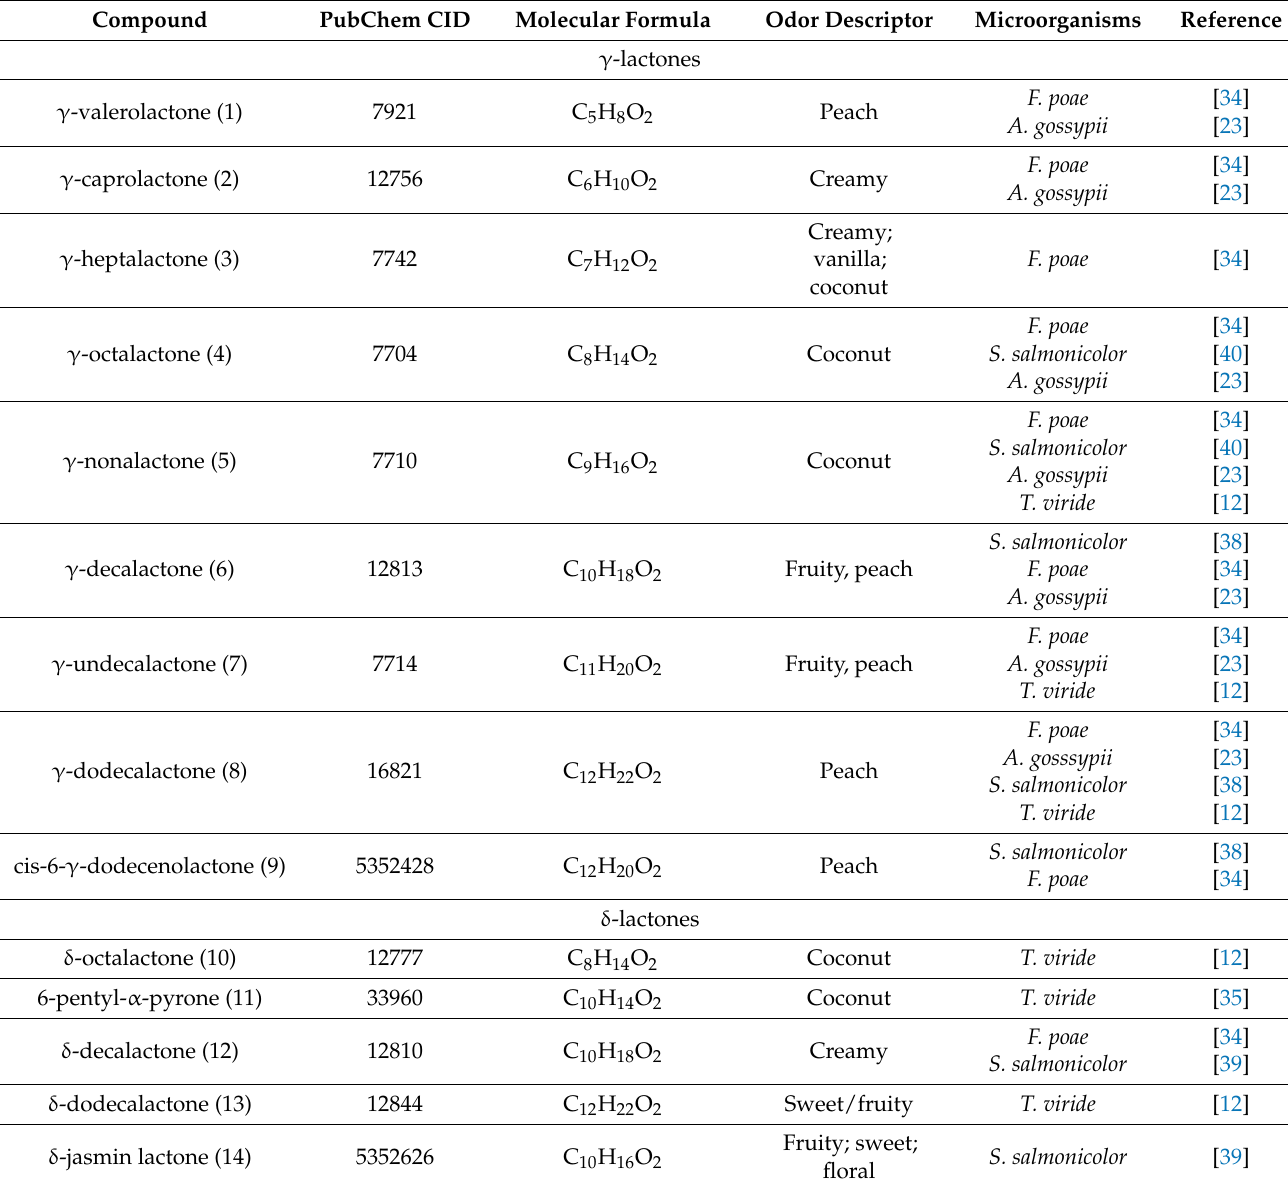
Table 1. Lactones produced by microorganisms through de novo